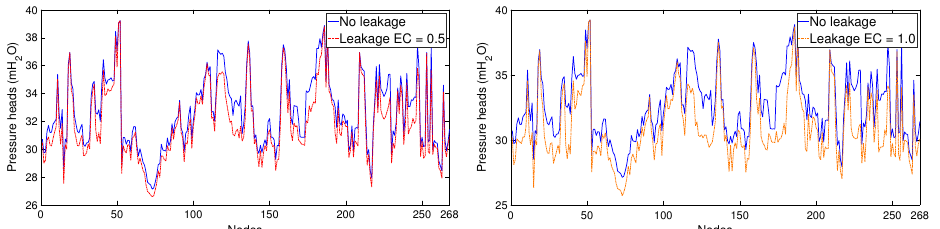
Figure 4. Comparing nominal and leak pressure head behaviour with demand uncertainty and measurement noise for